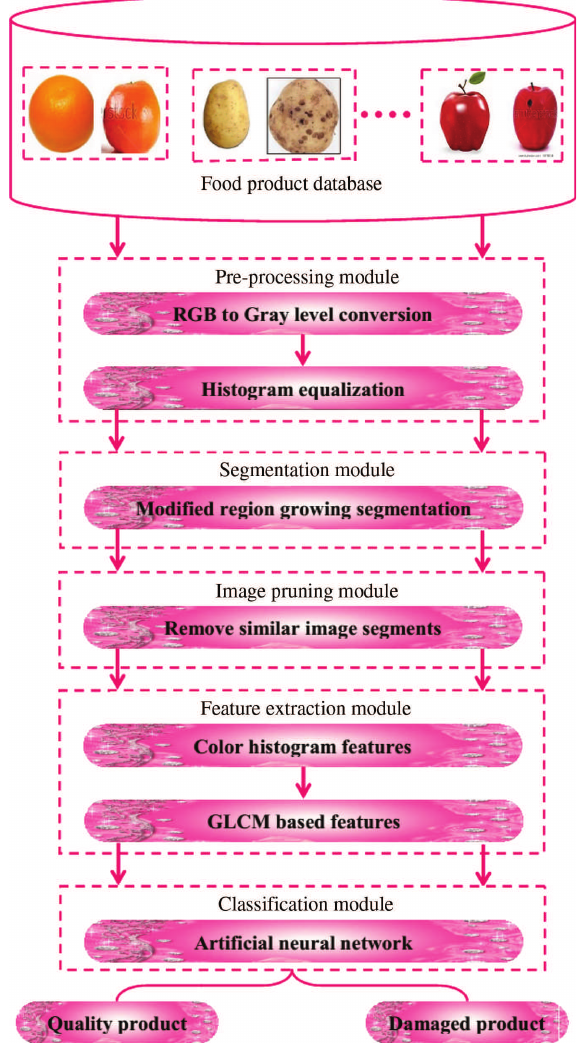
Figure 1: Overall Architecture of the Proposed Food Quality Grading